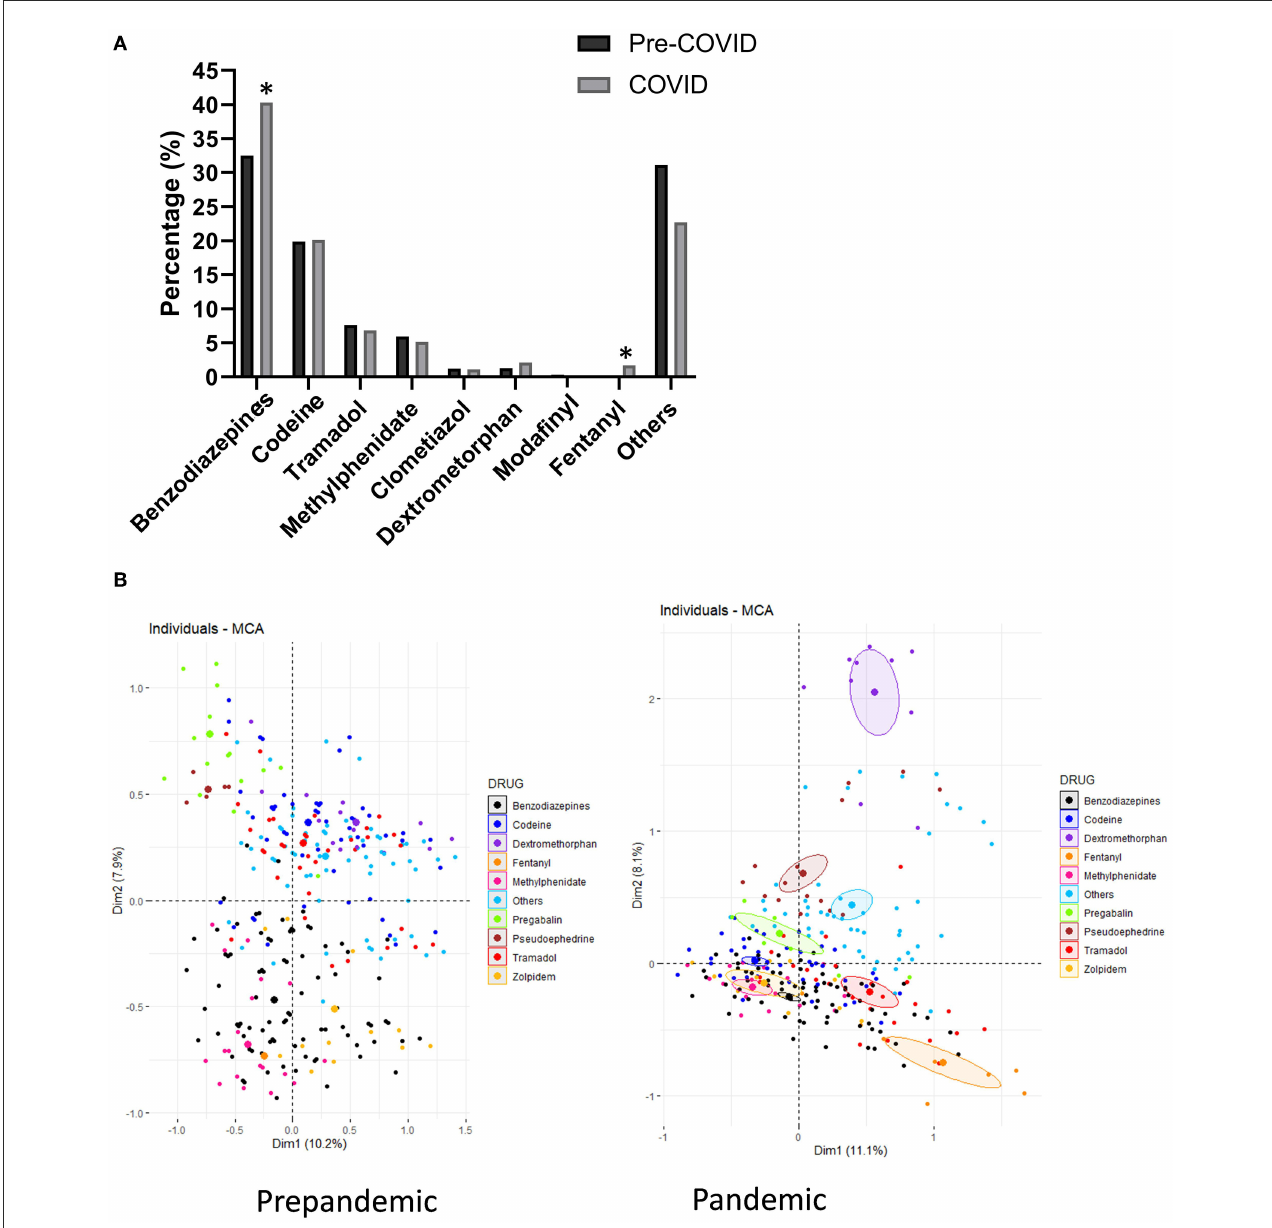
FIGURE3 Description and proportion of type of drug according to (A) both periods and (B) depiction by MCA analysis. Statistical differences: * p < 0.05 pandemic vs. pre-pandemic.